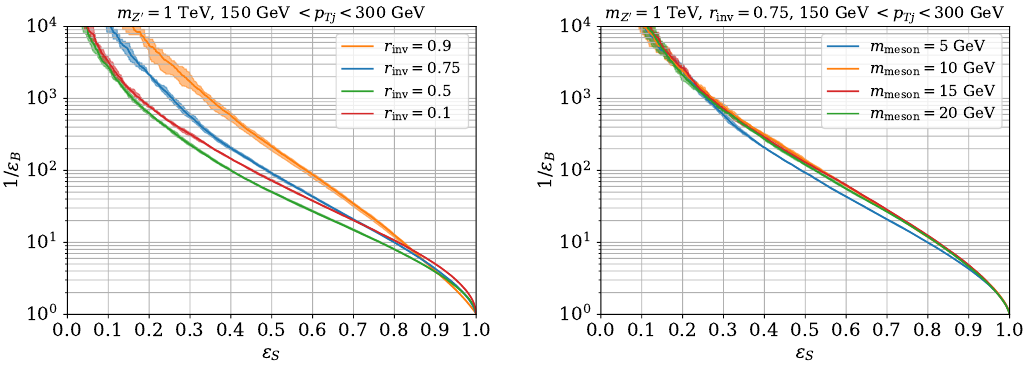
Figure 4: DGCNN ROC curves for the discrimination of dark showers from QCD for different values of r (left panel) and m (right panel). The error bands cor- inv meson respond to the spread obtained from five independent initialisations of the network.